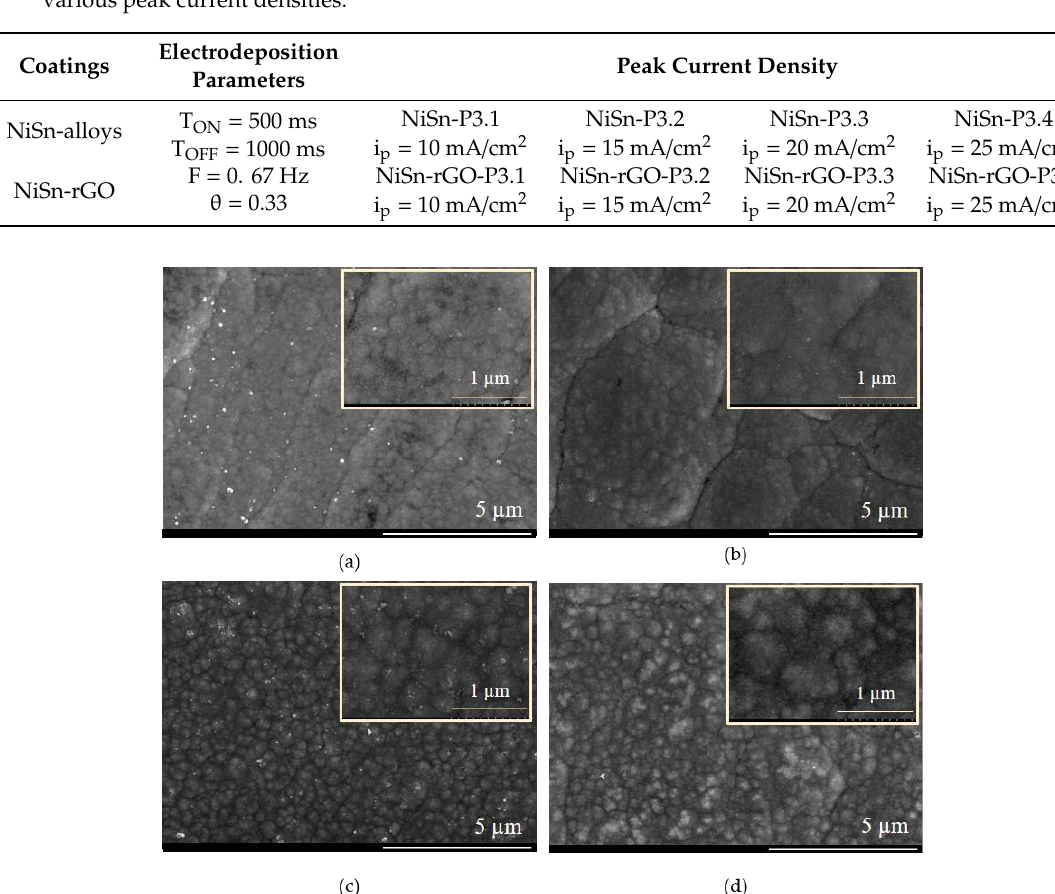
ff erent peak current densities: ( a ) NiSn-P3.1,